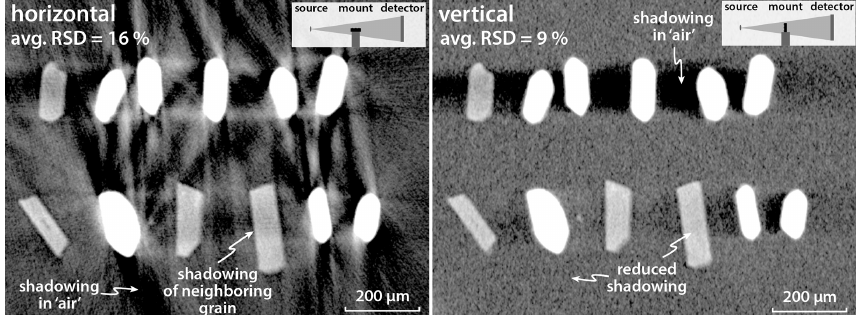
Figure 8. Slices of horizontal and vertical scans of the same grain mount show the reduction of artifacts for the vertical scan position relative to the horizontal scan position. Highly attenuating zircon (bright) grains produce shadowing artifacts that overlap with apatite (less bright) grains, altering the overall grayscale value measured in the apatite grains. Some shadowing still occurs in the vertical position but is much reduced relative to the horizontal position. This is reflected in the relative standard deviation (RSD) of the grayscale value within each set of grains. The arrangement of grains in a geometric pattern leads to amplification of artifacts. Note: photographs have increased contrast to highlight the differences in